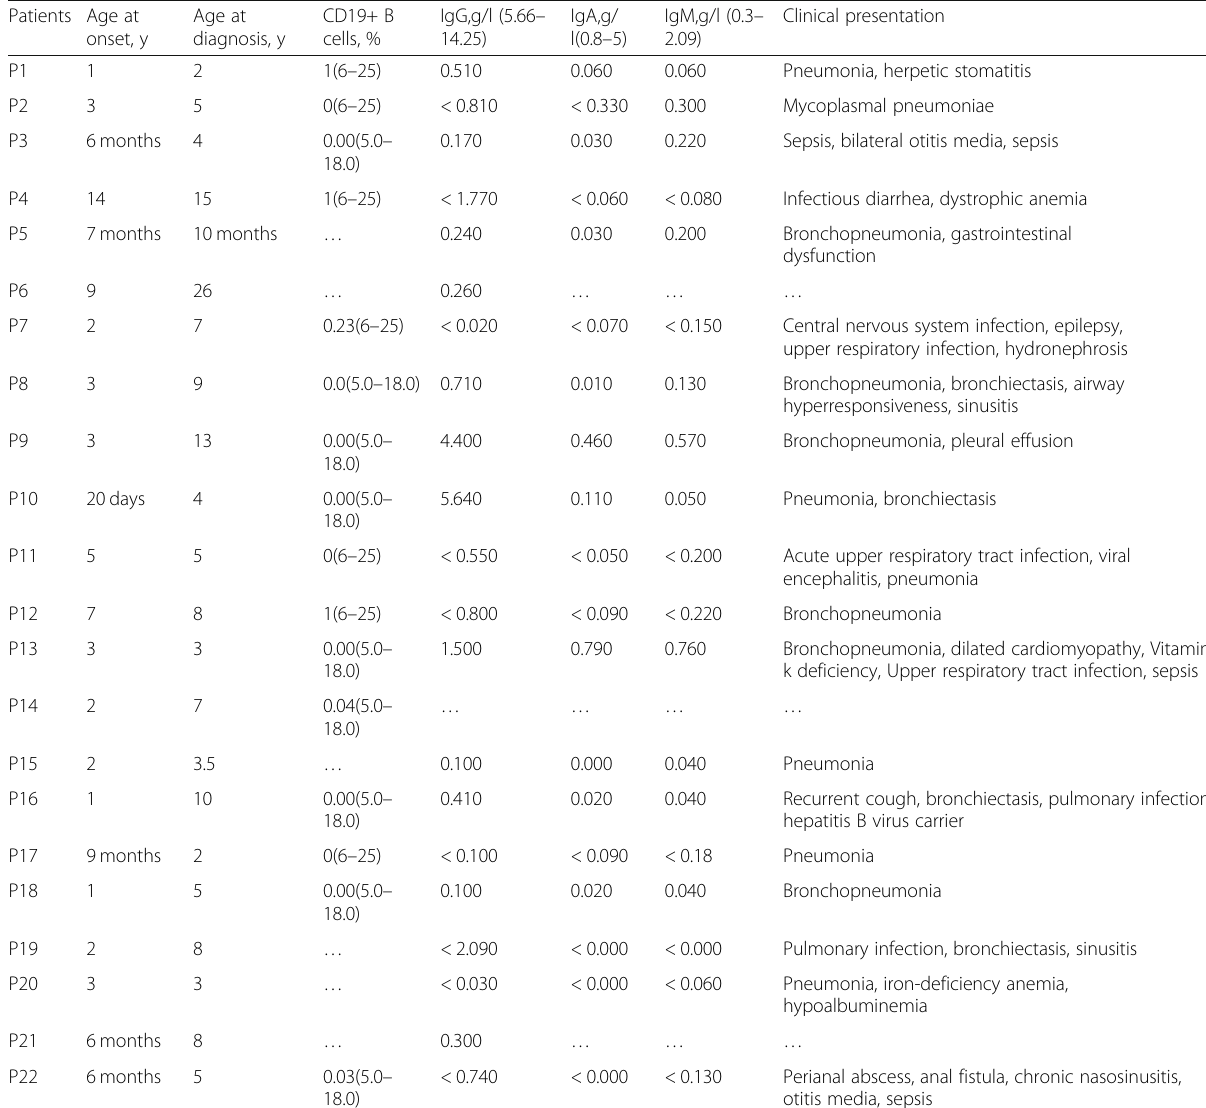
Table 1 Characteristics of 22 XLA male patients Patients Age at onset,